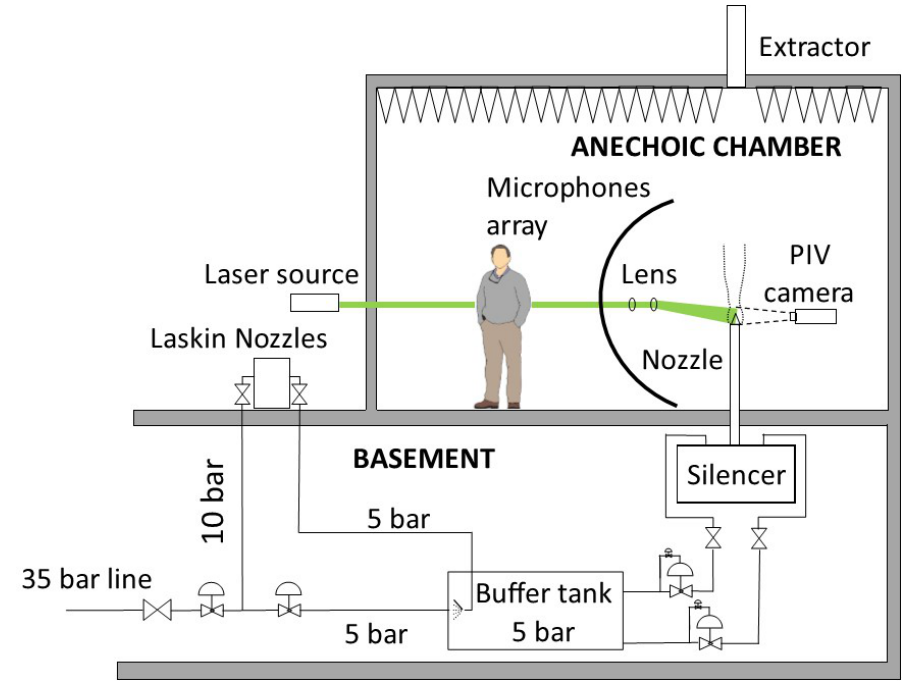
Figure 1. Sketch of the FAST final